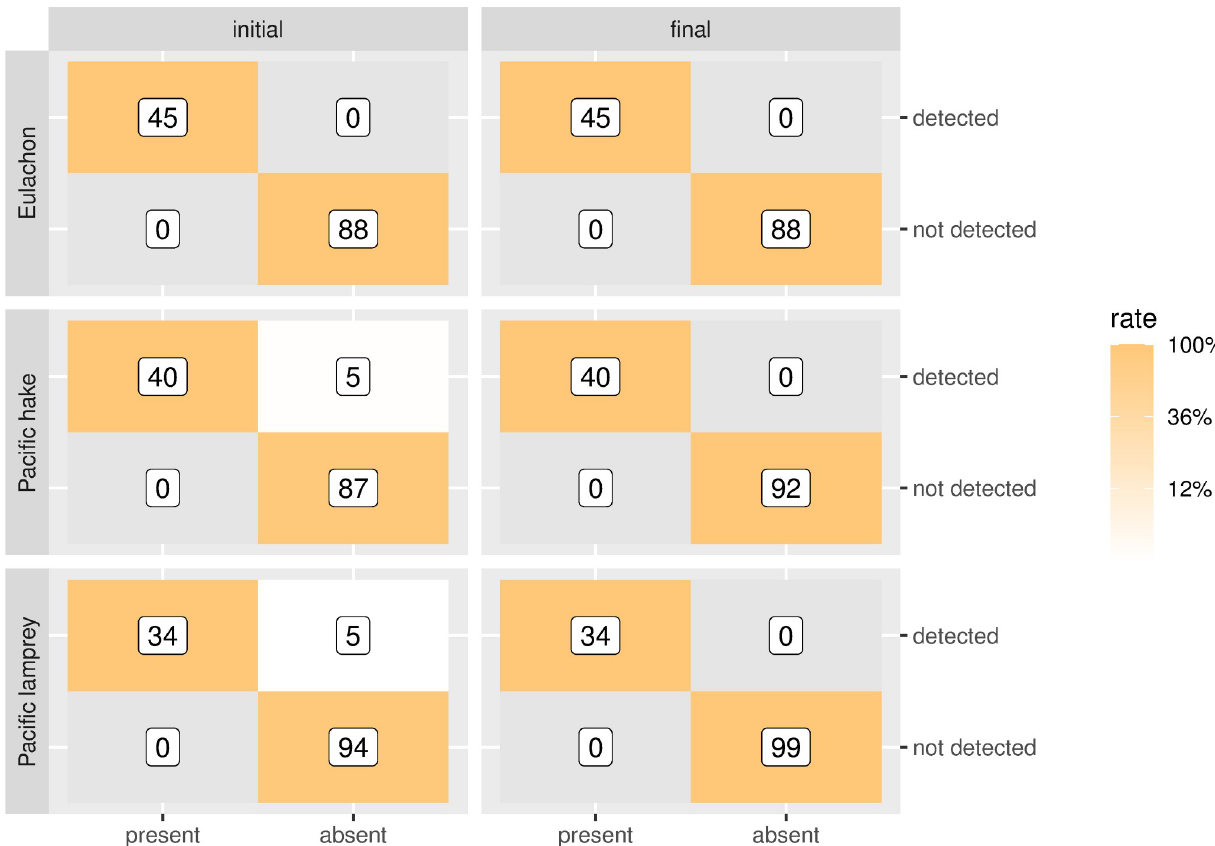
Fig 3. In vitro specificity results. Initial tests show the results of the qPCR with contaminated samples and final specificity is ascertained after sequencing the resulting amplicons. Color of the tiles shows the rate of the true (orange) or false positive or negative observation (light yellow). Numbers in the labels in the tiles are the number of samples accounted for in the observation at > 1 copy μ l -1